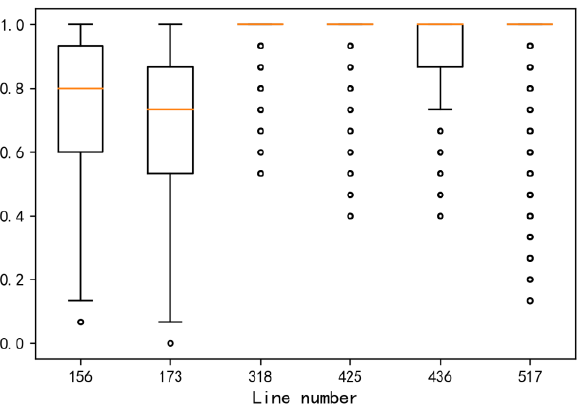
Figure 6. Display of test results. ( a ) Spectrogram generated by the Z-component waveform data of ZH-1 electric field VLF on 30 April 2019; ( b ) Detection results of horizontal lines marked by red dots; ( c ) Abnormal results marked by white lines.